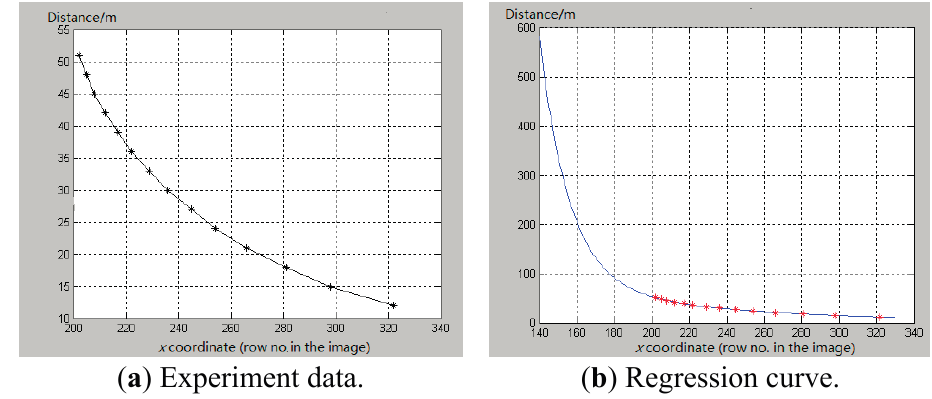
Figure 15. The range estimation regression